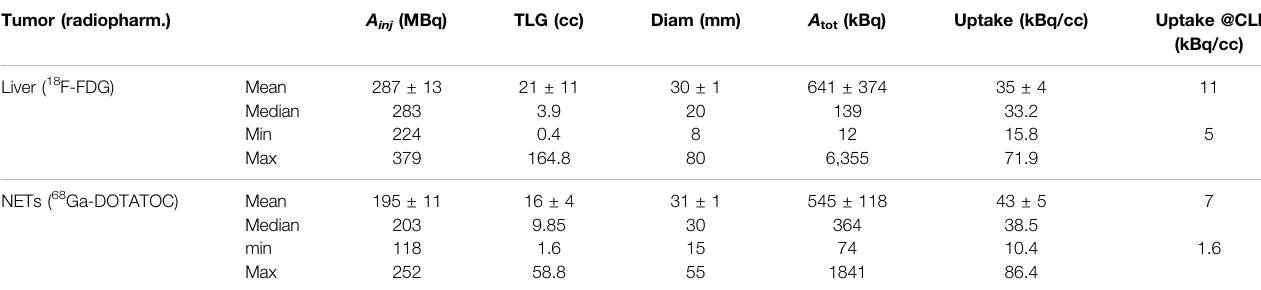
TABLE 3 | Summary of the injected activity ( A inj ), tumor dimension (TLG (cid:1) total lesion glycolysis) and diameter, total activity in the volume, uptake on PET/CT scans and decay-corrected at CLI time (4 h post-injection). Mean, median, minimum and maximum values are calculated over 15 patients in each group. Tumor